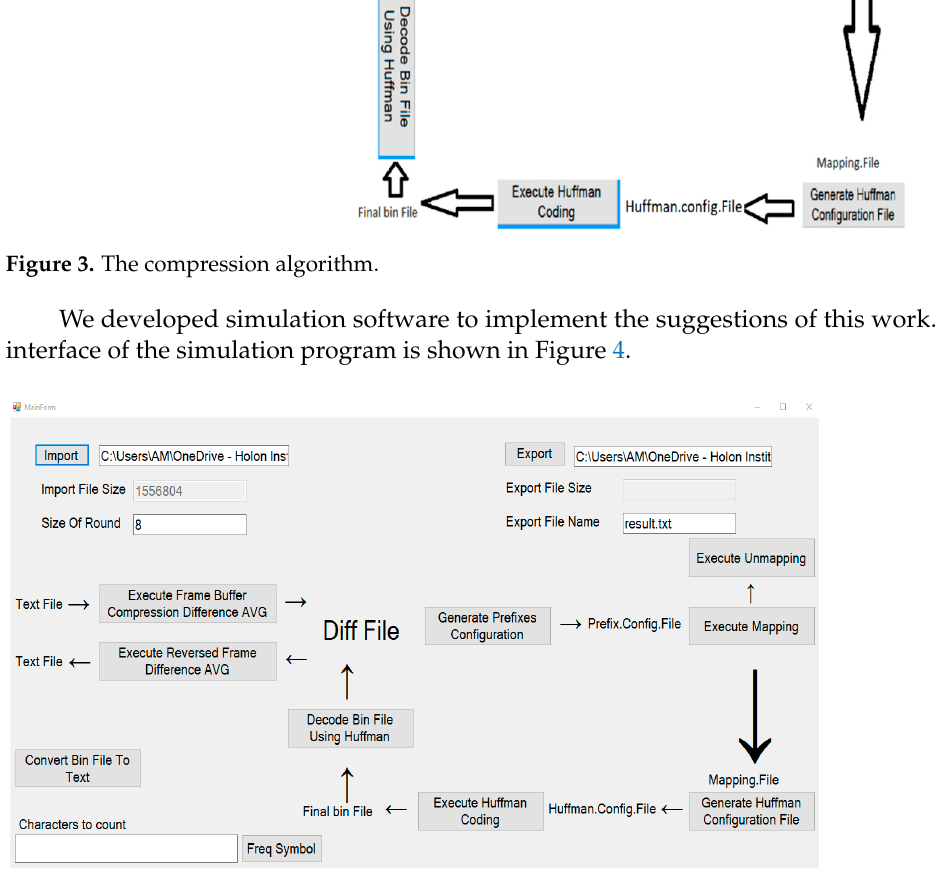
Figure 4. The simulation